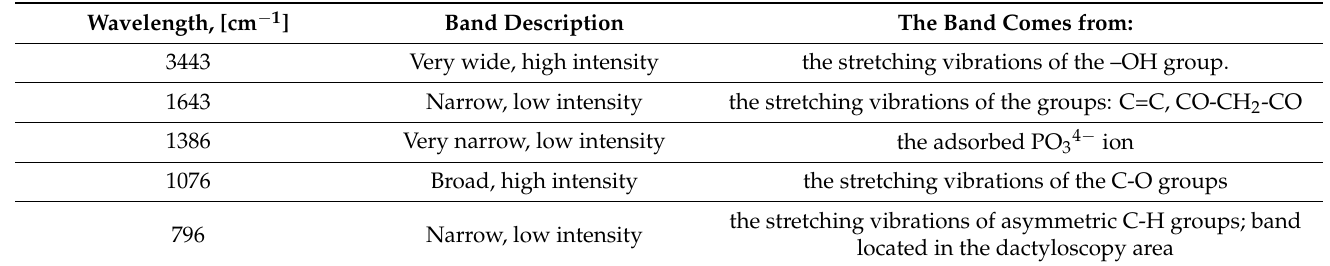
Table 5. Analysis of the FTIR absorption spectrum of Absodan Plus samples-characteristic bands. The Band Comes from: the stretching vibrations of the –OH